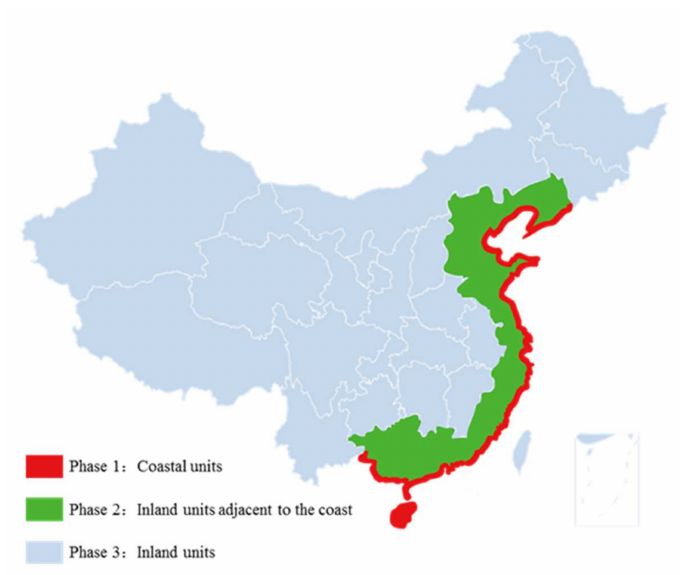
Figure 2. Regional distribution of China’s three-step